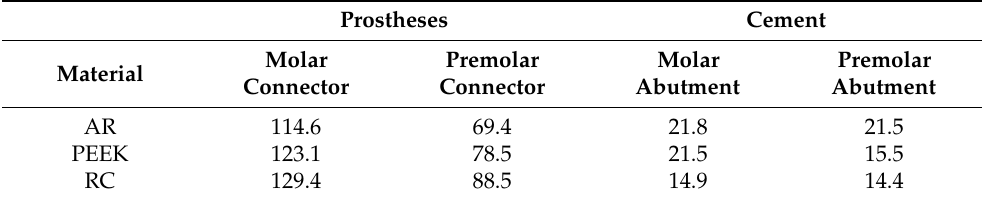
Table 2. Stress peaks (MPa) generated in the FDP and cement layers for each abutment tooth according to the evaluated restorative